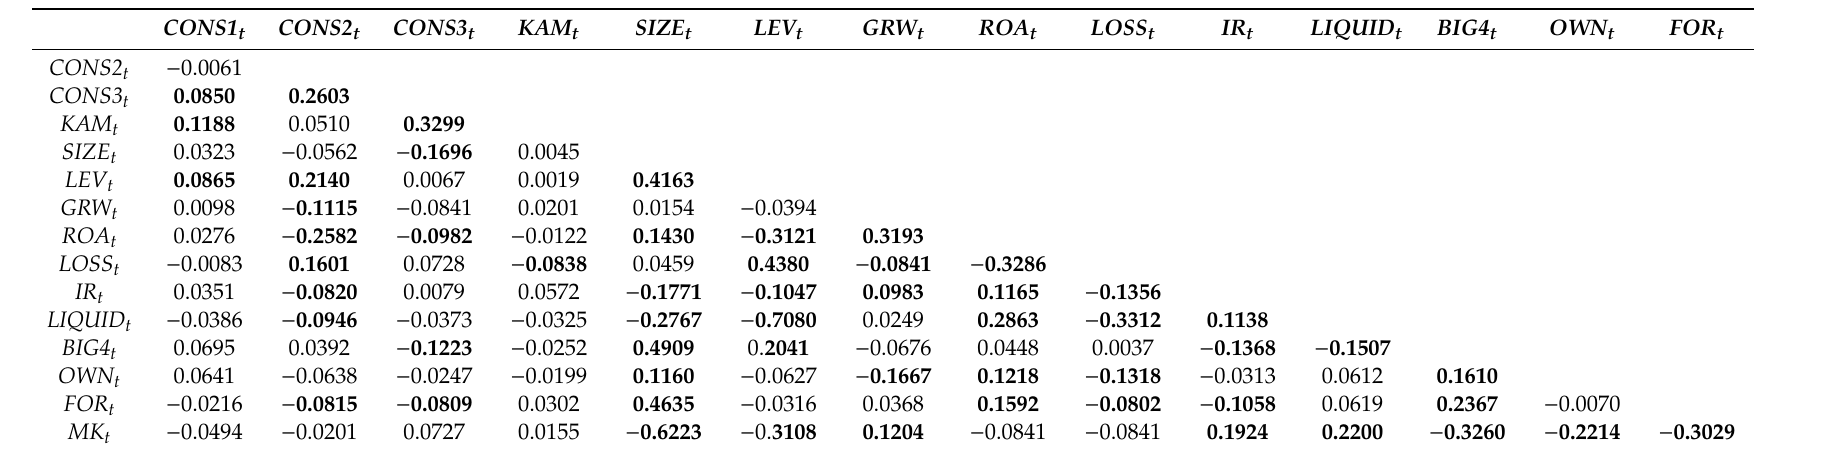
Table 3. Correlations among the